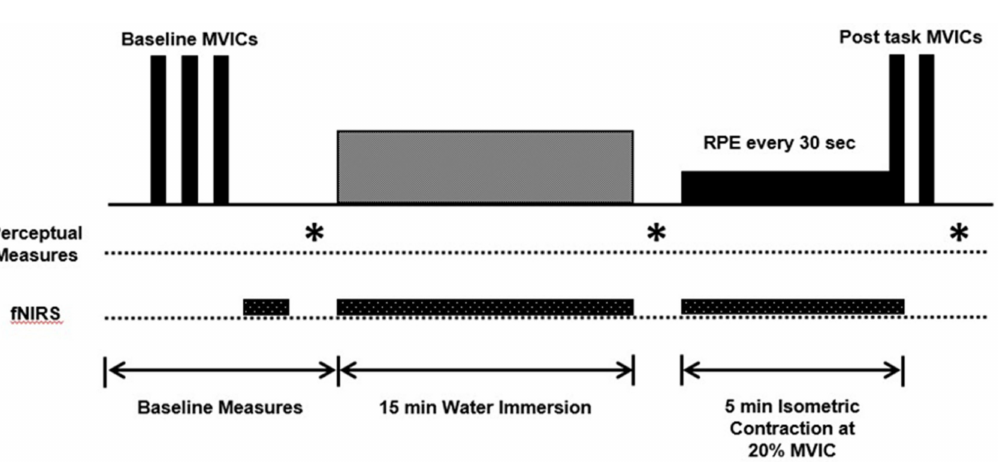
Figure 1. Experimental